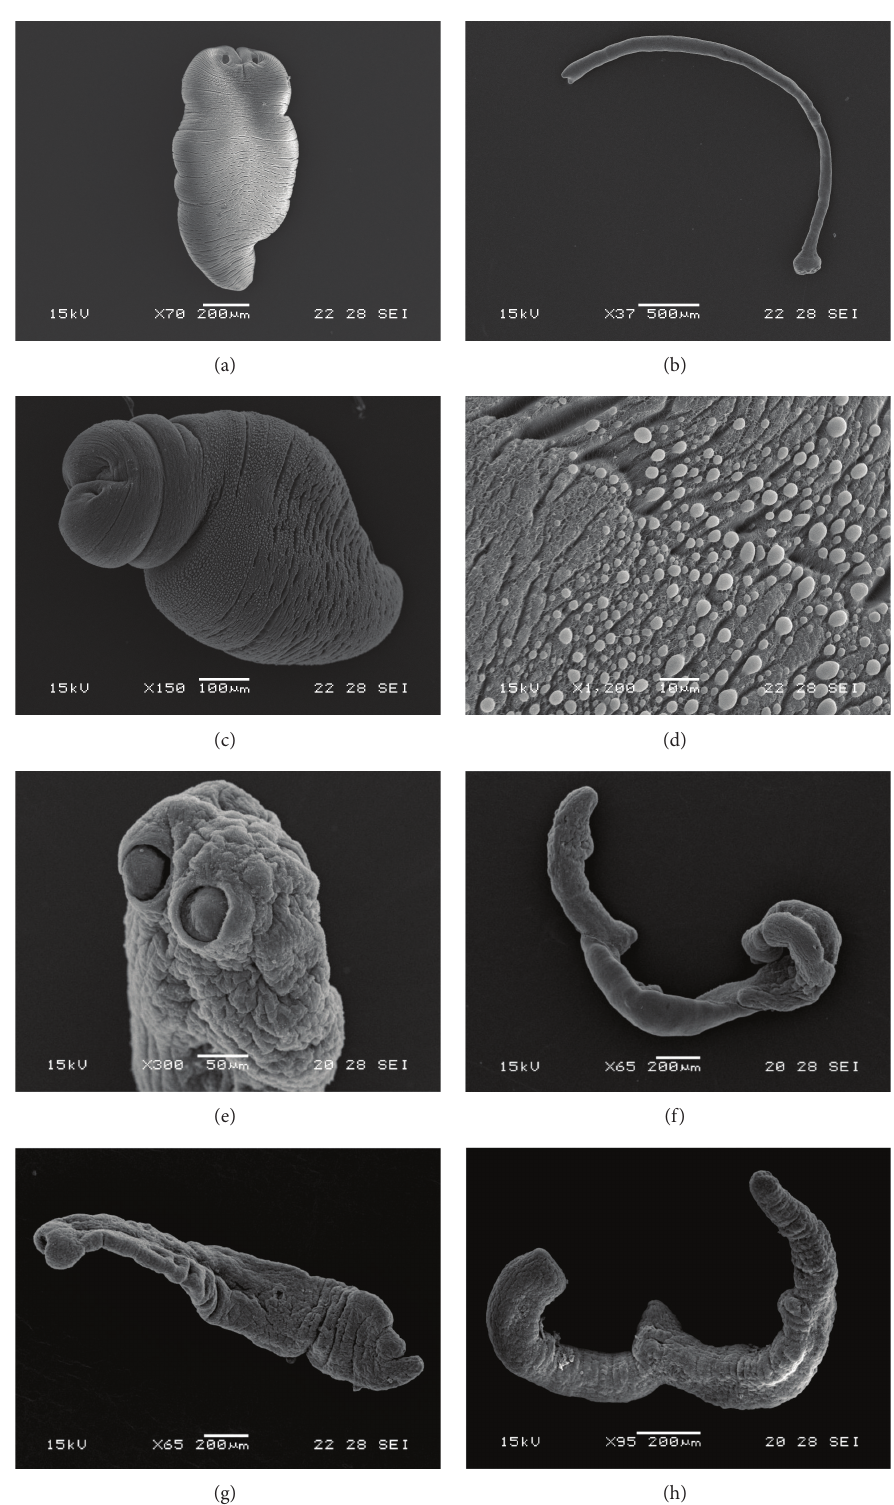
Figure 1: Scanning electron microscopy of Mesocestoides corti tetrathyridia incubated in vitro with thymol. (a) Control tetrathyridium (70x). (b) Altered tetrathyridium after 1h following incubation (100 𝜇 g/mL). Note the elongation of the body (37x). (c) Thymol-treated tetrathyridium. Observe the blebs and depressions (1h, 25 𝜇 g/mL, 150x). (d) Detail of blebs and depressions (1h, 25 𝜇 g/mL, 150x). (e) Alterations in the tegument of the suckers region (1h, 150 𝜇 g/mL, 300x). (f) Larvae showing the surface damage produced by thymol (1h, 200 𝜇 g/mL, 65x). (g) Altered tetrathyridium (1h, 250 𝜇 g/mL, 65x). The body appeared elongated and flattened. (h) Completely altered tetrathyridium after overnight incubation (250 𝜇 g/mL,